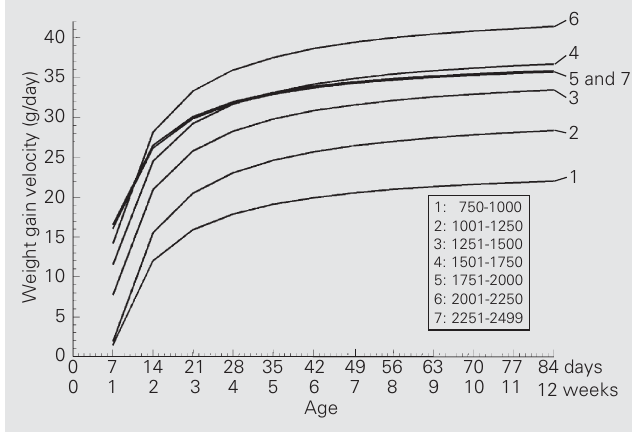
Figure 4. Mean daily weight gain velocity per kg (g kg -1 day -1 ) of ad- equate-for-gestational-age preterm newborns by birth weight category.